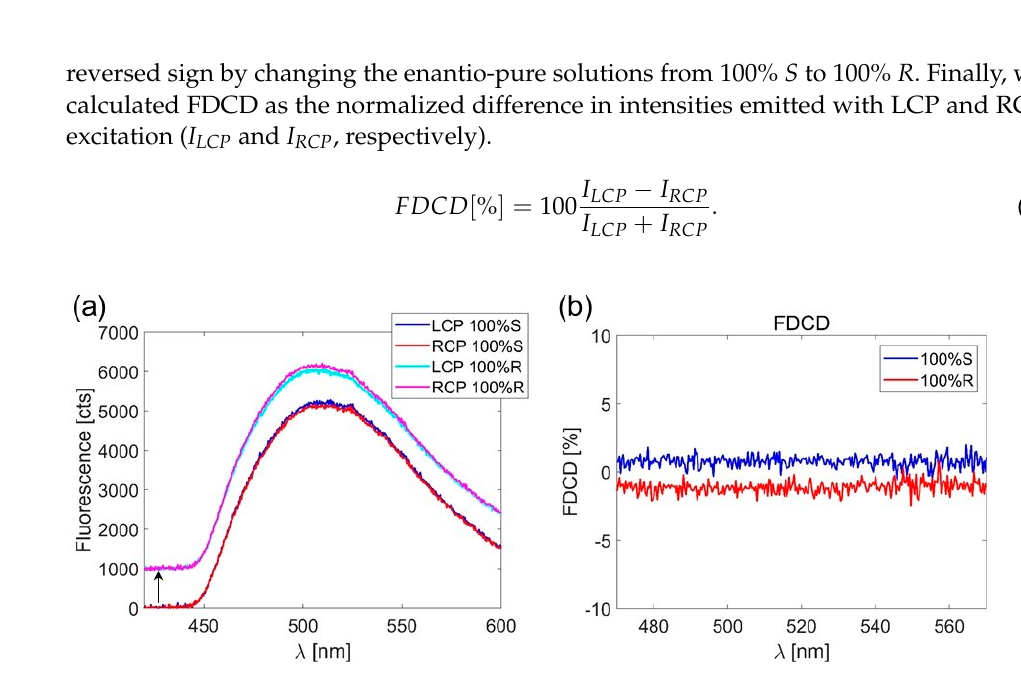
Figure 5. ( a ) Fluorescence spectra of DMF solutions with (red, blue curves) 100% S and 100% R (cyan, magenta curves), under LCP and RCP excitation. ( b ) FDCD spectra of the two solutions.